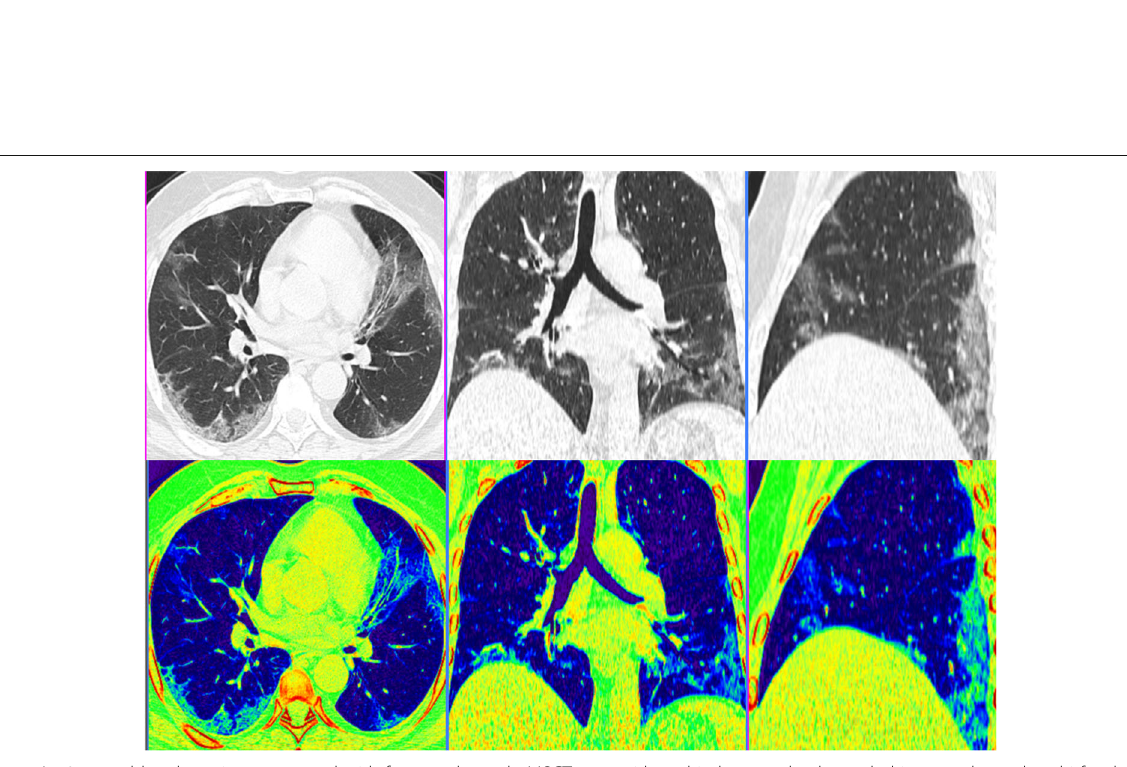
Fig. 4 A 48-year-old male patient presented with fever and cough. MSCT scan with multi-planar and color-coded images showed multi-focal bilateral predominantly peripheral subpleural patchy ground glass opacities with septal and vascular thickening. CT-SSS was 11 and serum LDH was 239. The patient exhibited non-severe disease